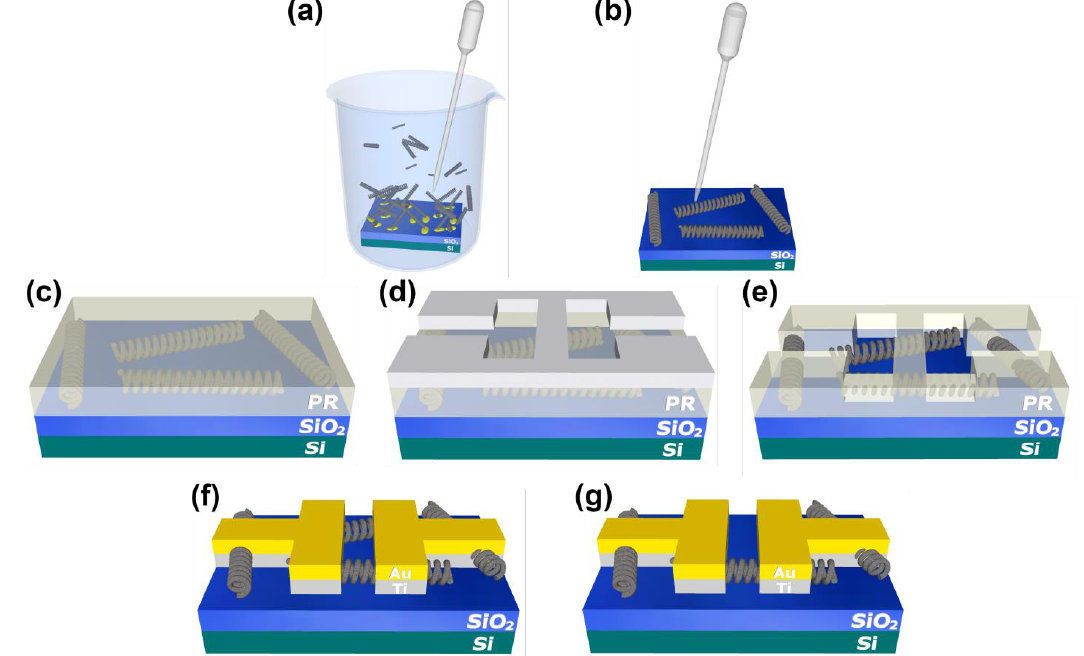
Figure 2. Schematic representation of the device fabrication process. ( a ) GUITAR-coated nanosprings (G-NSs) released into IPA and ( b ) drop-cast onto a SiO 2 /Si substrate. ( c ) Photoresist (PR) is spun onto the substrate. ( d ) UV light is exposed to photoresist with a chrome mask in place to create the electrode pattern. ( e ) The photoresist exposed to UV is removed with a developer. ( f ) Ti and Au are deposited via thermal evaporation and the remaining photoresist is removed in a solution of photoresist remover. ( g ) The electrode gap is cleared of G-NSs via a micromanipulator until one G-NS remains with sufficient contact.